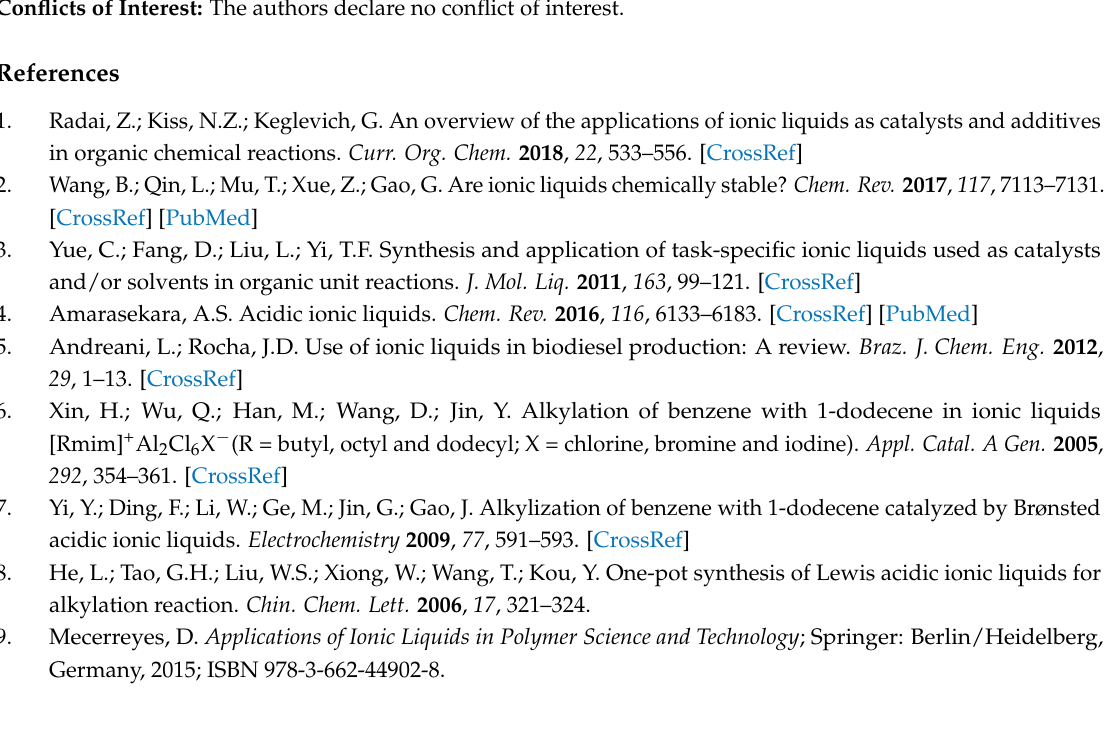
Supplementary Materials: The following are available online, Figures S1–S16: structures of optimized ionic liquids, Tables S1–S12: calculation data of Fukui function and dual description, Tables S13–S28: Cartesian coordinates of